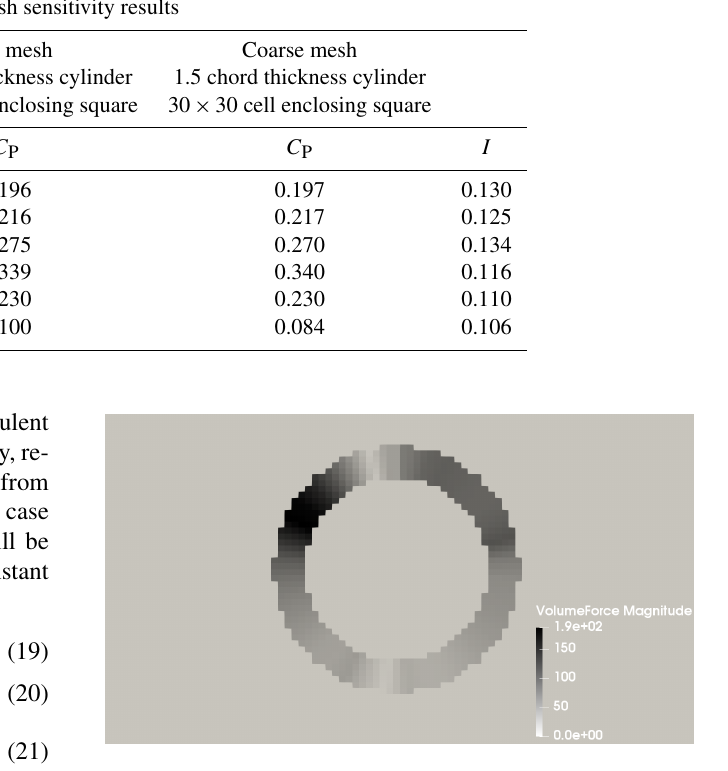
Figure 5. Volumetric forces acting on the cylinder. Flow goes from left to right. Free stream speed is 8ms − 1 , with a coarse